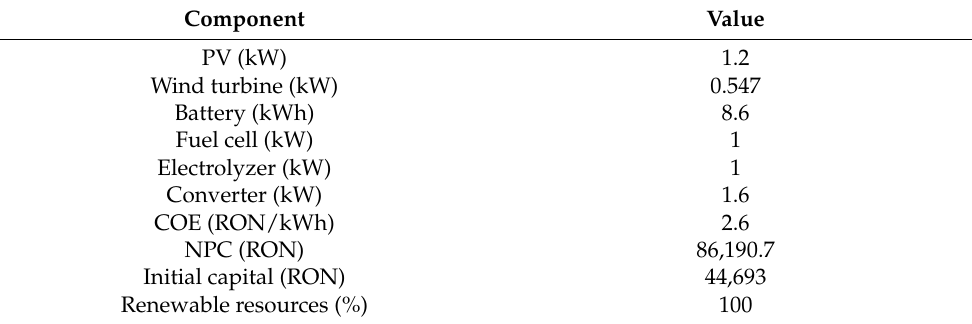
Table 10. The simulation results for the second case using iHOGA simulator.